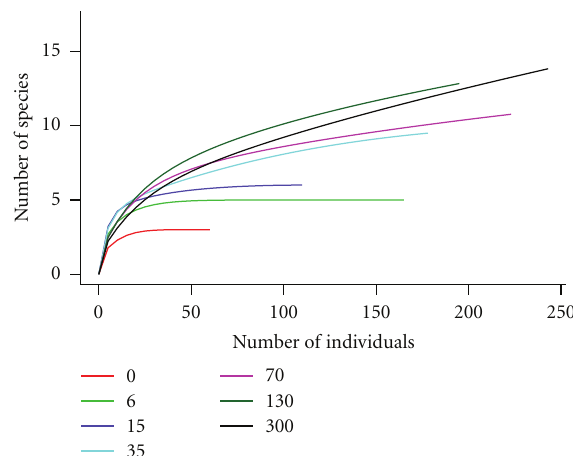
Figure 7: Individual-based species rarefaction curves for crickets communities within di ff erent forest patches. All 95% confidence intervals (CI) overlapped, showing that there was no significant di ff erence between forests patches. We removed the dotted lines that represent CI, so as to allow visualization of trends.